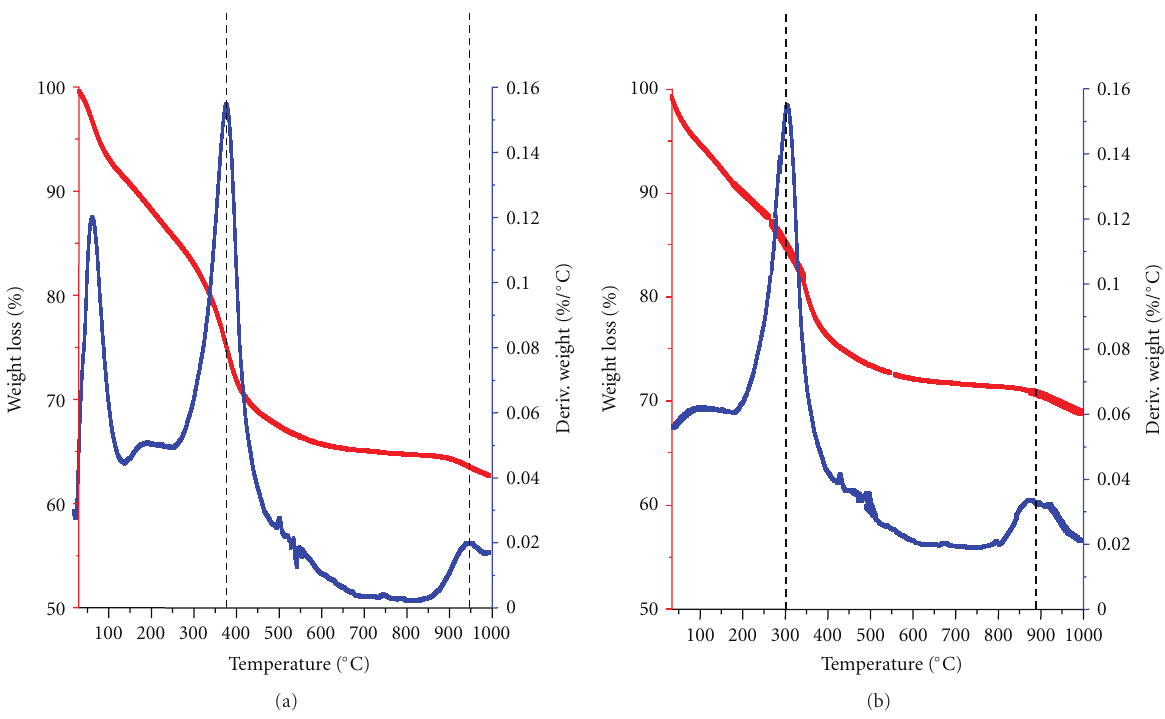
Figure 1: The DT-TG curves sample powders prepared (a) without and (b) with microwave pretreatment.